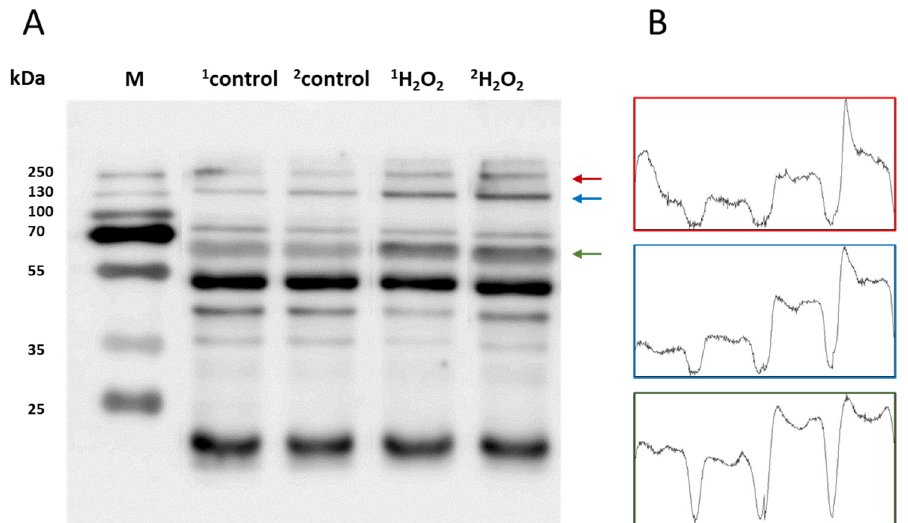
Figure 5. ( A ) Identification of MDA-protein adducts in homogenates of porcine skin cells. Lanes 1–2 show control samples, while lanes 3–4 are skin samples treated with H 2 O 2 (10 mM) ( B ). Quantification of protein bands (by densitogram analysis) from an anti-MDA blot is presented, and proteins of interest are indicated by arrows.